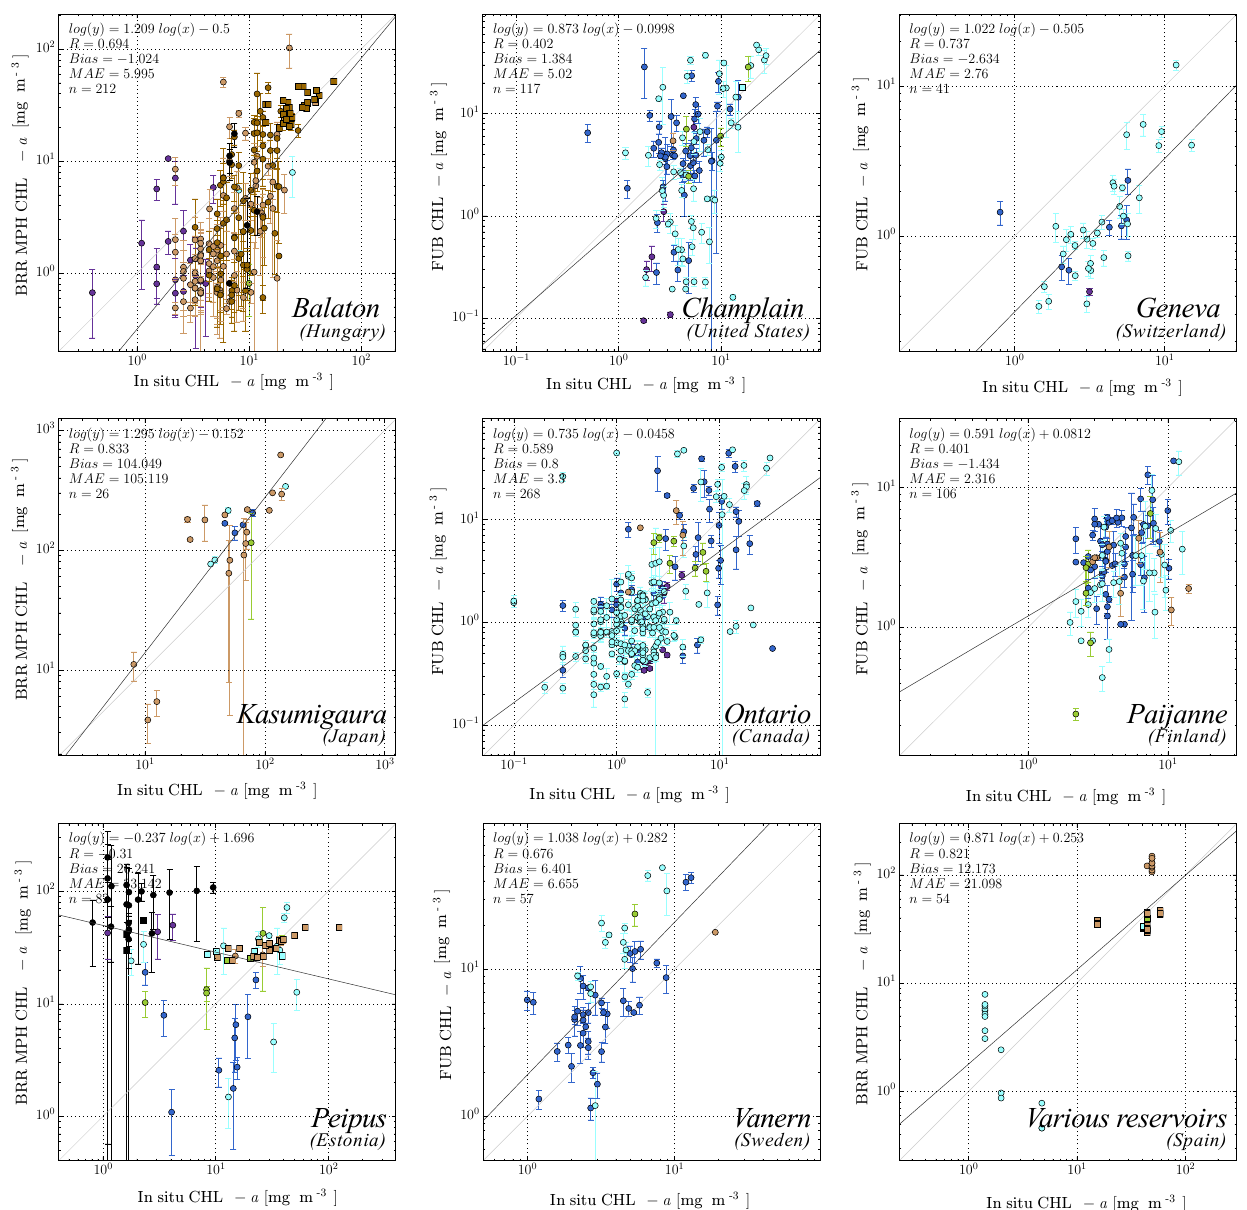
Figure 7. Matchup comparisons between remotely sensed chl- a and monitoring measurements. Colours represent the dominant OWT in the nine matchup pixels according to Fig. 2 (black: OWT classification not possible), and error bars indicate their standard deviation.